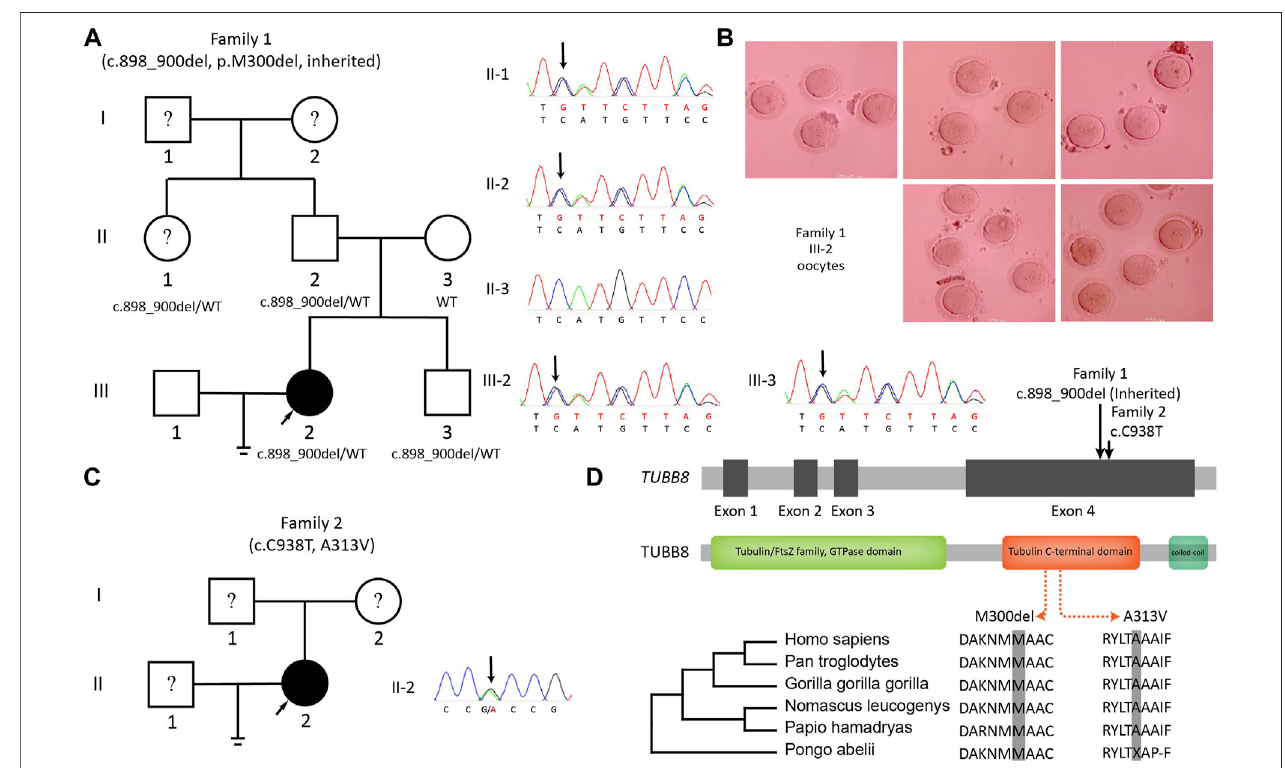
FIGURE 3 | Variants on TUBB8 and its conservation. (A) The pedigree and Sanger sequencing of Family 1. (B) Oocytes from III-2 (Family 1) arrested in MI. (C) The pedigree and Sanger sequencing of Family 2. (D) Conservations of variant sites of TUBB8.